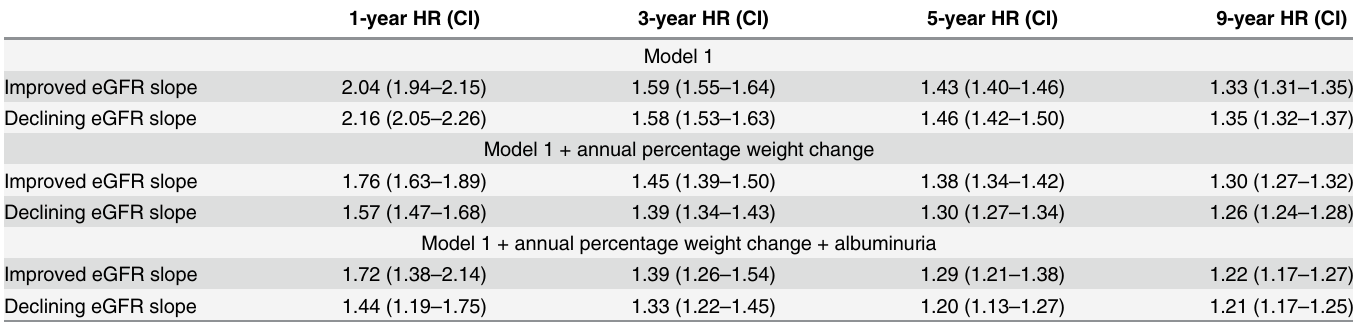
Table 2. Change in kidney function and the risk of death. Model 1 adjusted for age, race, gender, diabetes mellitus, hypertension, cardiovascular dis- ease, hyperlipidemia, peripheral artery disease, cerebrovascular disease, chronic lung disease, hepatitis C, HIV, dementia and eGFR at time of cohort entry (T0). Reference group is patients with stable kidney function (eGFR